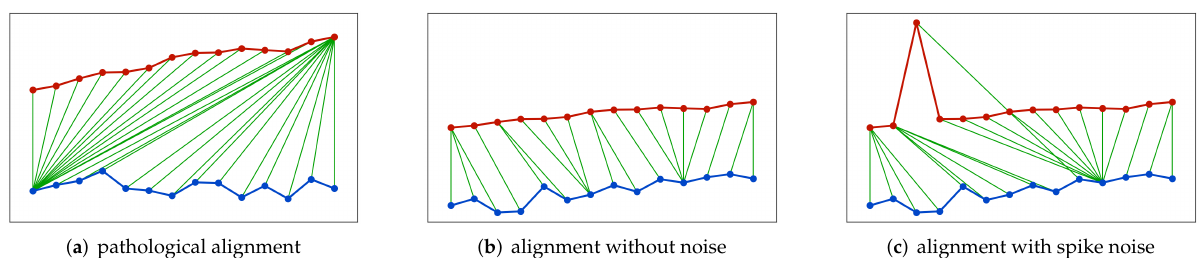
Figure 1. Examples of pathological alignment and alignments with or without spike noise generated by DTW. ( a ) pathological alignment; ( b ) alignment without noise; ( c ) alignment with spike